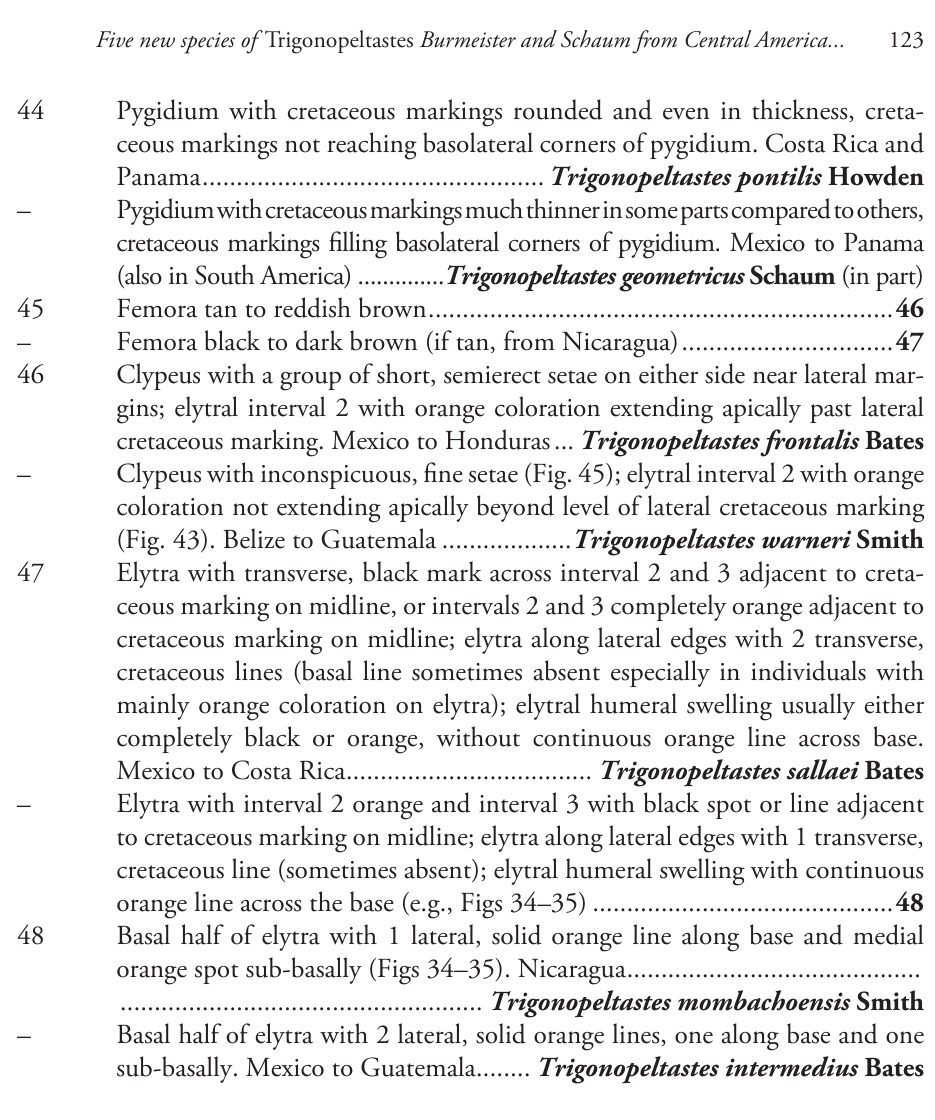
Checklist of the New World Trichiini Apeltastes Howden, 1968 Apeltastes chiapasensis Howden, 1994 – Mexico Apeltastes elongatus Howden, 1968 –